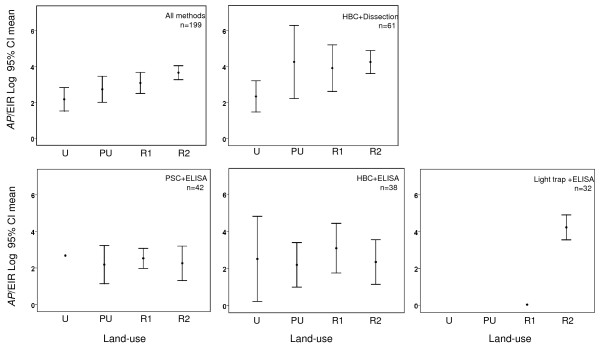
Graphs of APfEIR estimates by four main measurement methods and land use categories.